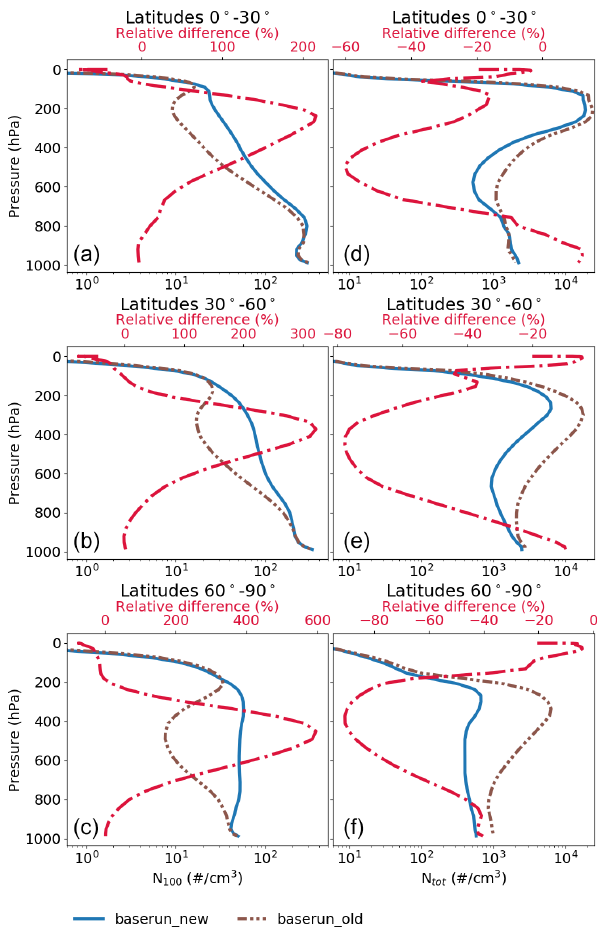
Figure 3. Vertical profiles of the N 100 (a–c) and N tot (d–f) con- centrations, simulated with old and current in-cloud wet deposition schemes in different latitude regions.